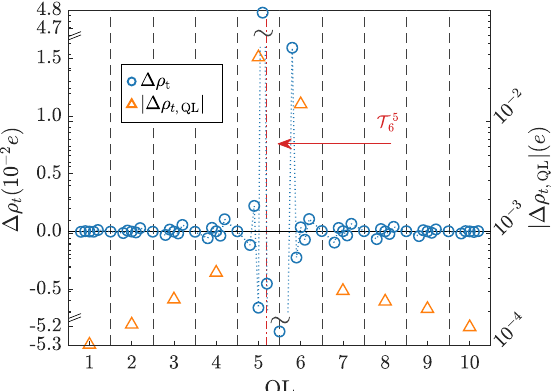
Figure A2. (left axis) Distribution of the charge transfer ∆ ρ t caused by the presence of a twin plane ( T 5 ) in the multilayer composed of 10 Bi 2 Se 3 QLs. Each data point denotes a particular atomic layer 6 or an ES representing the vdW gap. (right axis) Dependence of the variance of the charge transfer at particular QLs. Dashed lines separate QLs and denote position of the vdW